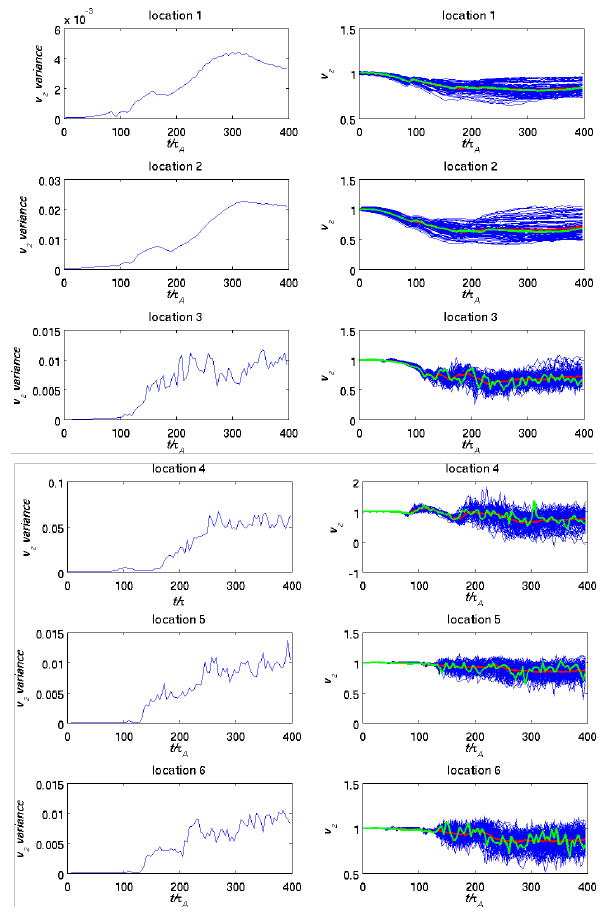
Figure 5. Time evolution of the ensemble variance for the normalized z v (left panels) and time evolution of z v 1 Fig. 5. Time evolution of the ensemble variance for the normalised v z (left panels) and time evolution of v z for all the ensemble mem- for all the ensemble members (right panels) at the selected diagnosis locations. The red curve represents the 2 bers (right panels) at the selected diagnosis locations. The red curve average of the ensemble and the green curve refers to the reference simulation, where no perturbation is applied 3 represents the average of the ensemble and the green curve refers to the source surface inputs. z v is normalized to the Alfvén speed A v and the time to the Alfvén time A  . Note 4 to the reference simulation, where no perturbation is applied to the that the left and right z v scales are not common to the six diagnosis points. 5 source surface inputs. v z is normalised to the Alfvén speed v A and the time to the Alfvén time τ A . Note that the left and right v z scales are not common to the six diagnosis